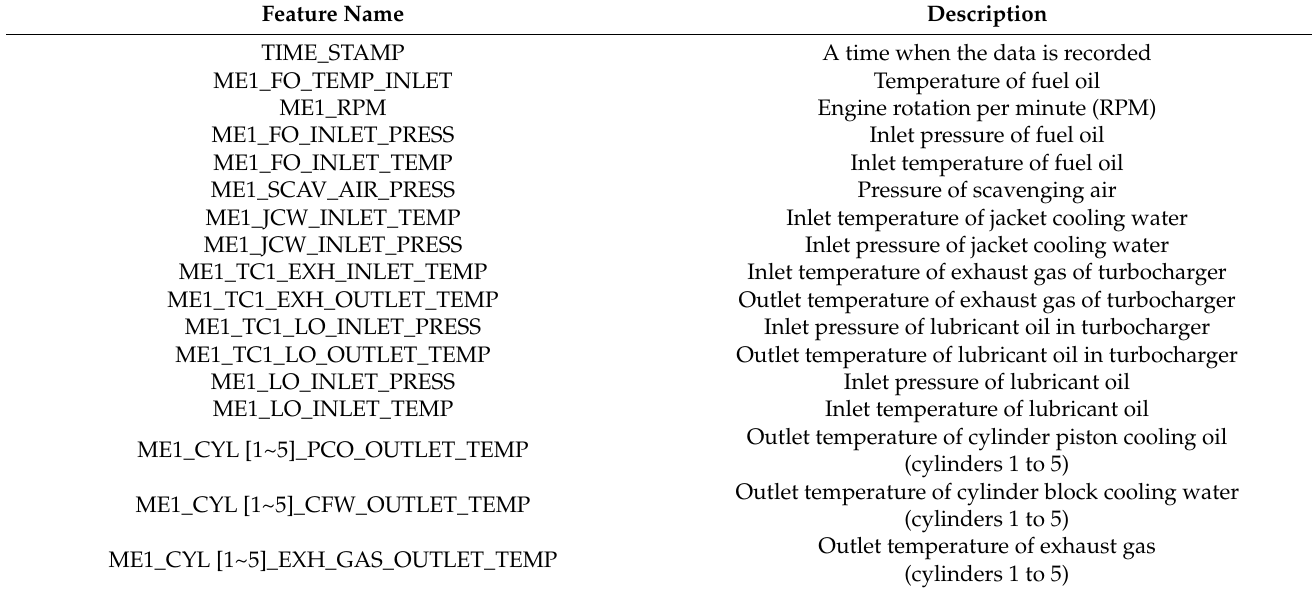
Table 2. Data features